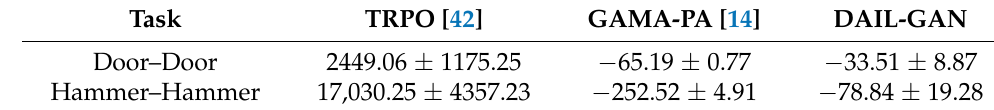
Table 4. The performance of the proposed models on high-dimensional tasks. These scores represent the cumulative rewards obtained from executing a learned policy in the simulator, averaged over 100 episodes.